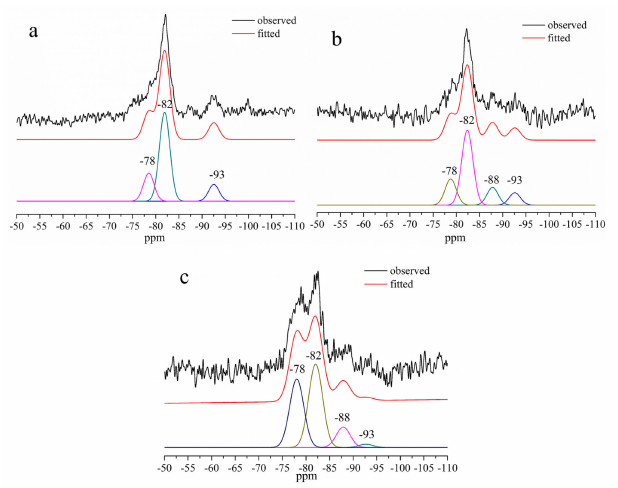
Figure 6. 29 Si MAS–NMR spectra of Al-tobermorite of various Al / (Al + Si) molar ratios. ( a ): Al / (Al + Si) = 0, ( b ):Al / (Al + Si) = 0.1, and ( c ):Al / (Al + Si) =